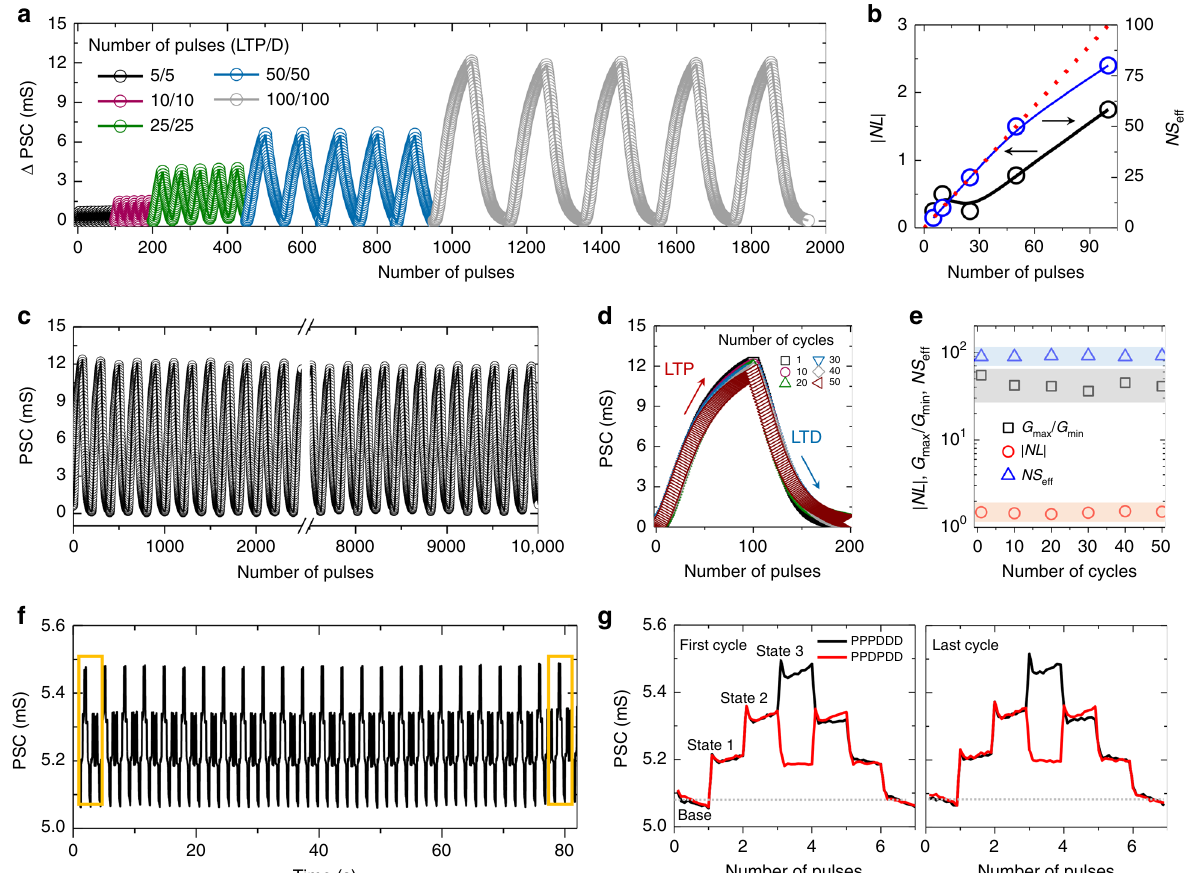
Fig. 4 Operational stability of vertical synaptic device. a LTP/D characteristics of vertical crossbar synapse array under application of various potentiation/depression pulse sets. b Plots of |NL| and NS eff as functions of pulse number for single cycle. c LTP/D characteristics of vertical synaptic device over 50 cycles. Number of potentiation/depression pulses for single cycle was set to 100/100. d Cycle-to-cycle variations of LTP/D curve for 50 cycles. e Plots of G max /G min , |NL|, and NS eff for 50 LTP/D cycles. f State stability under application of random combinations of potentiation/depression pulses with amplitudes of − 3 V/ + 2 V. g Overlapping of PSC plots in the fi rst and last cycles of regular (PPPDDD) and irregular (PPDPDD) pulse